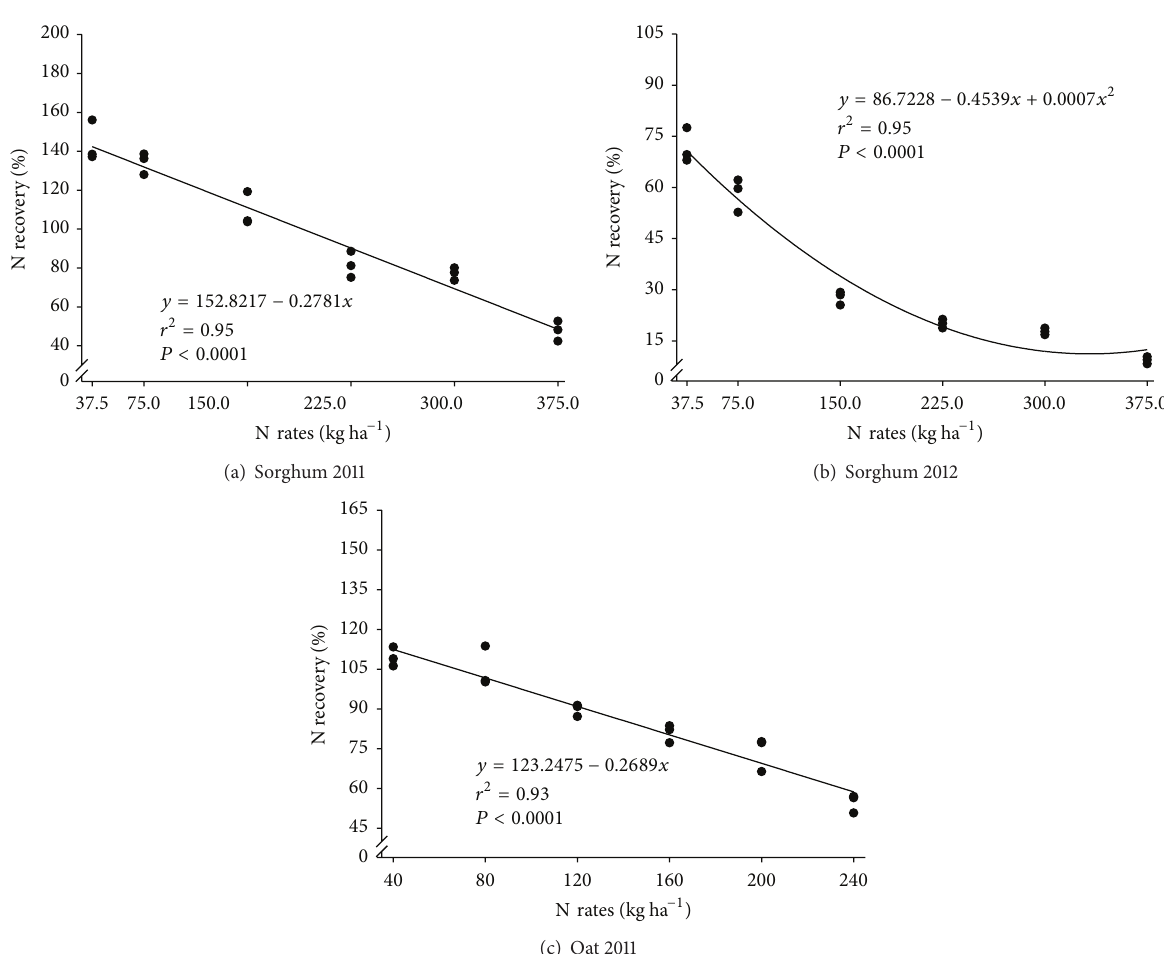
Figure 4: Nitrogen efficiency (%) by the forage of sorghum in the summer seasons of 2010/2011 (a) and 2011/2012 (b) and black oat in the winter season of 2011 (c), under nitrogen